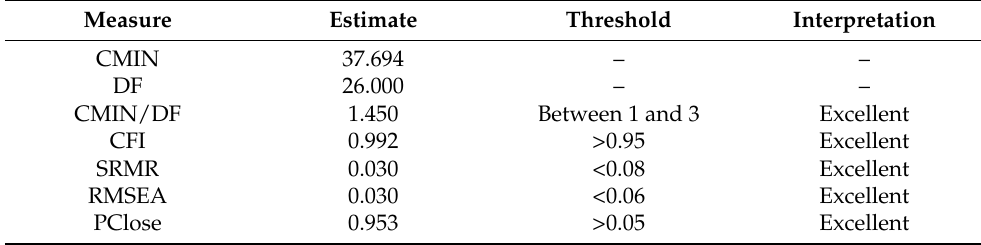
Table 4. Model fit of the structural